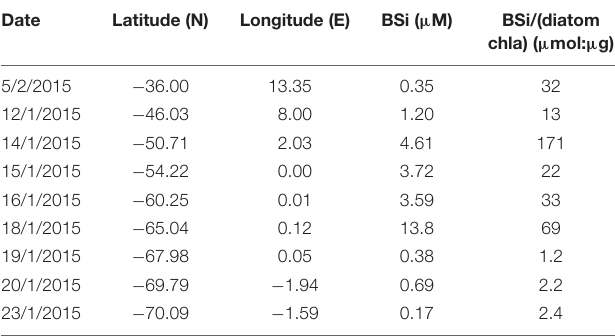
TABLE 4 | Biogenic silica (BSi) and ratio of BSi versus diatom-chla concentration (see Supplementary Table S7 for diatom-chla concentration values) determined at eight stations across the Atlantic sector of the Southern Ocean (see Figure 1 for cruise